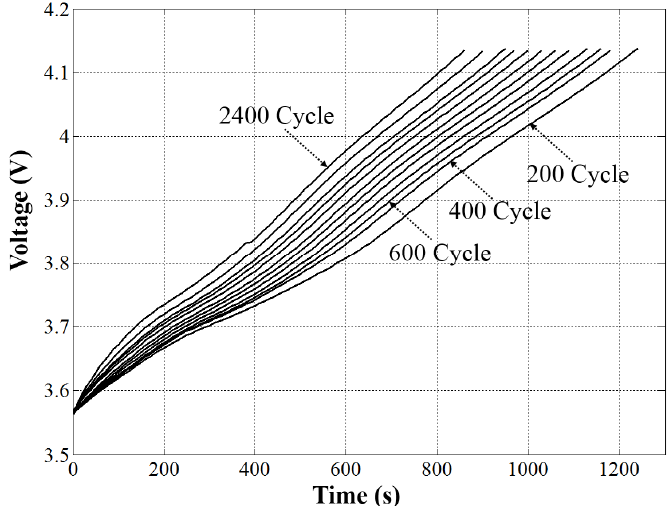
Figure 3. Voltage charge curve at various cycles in the battery experiment at 45 °C in 2C-rate condition with full charge and